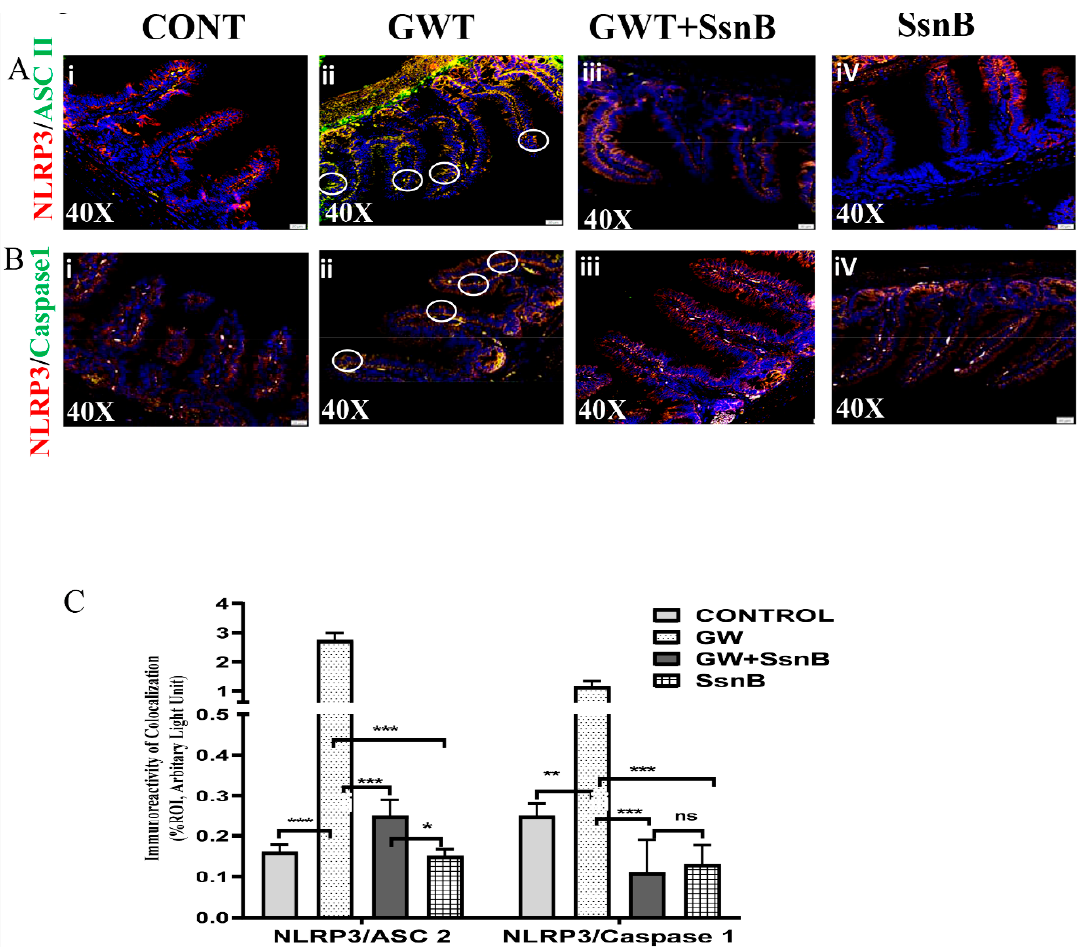
Figure 4. SsnB attenuates GW chemical-induced nod-like receptor protein 3 (NLRP3) inflammasome activation in the GWI mouse model. Activation of TLR4 signaling by HMGB1 may further activate the NLRP3 inflammasome complex, which exacerbates a pro-inflammatory response through secretion of inflammatory cytokines. The colocalization study of NLRP3 (red) / ASC2 (green) (Figure 4A) and NLRP3 (red) / Caspase 1 (green) (Figure 4B) was performed using an immunofluorescence microscopy in small intestine sections of CONT ( n = 3) (wild-type mice which were treated with vehicle), GW ( n = 3) (GW chemical exposed group), GW + SsnB ( n = 3) (group exposed with GW chemicals and SsnB), and SsnB ( n = 3) (group treated with SsnB only). Colocalizations were observed in the epithelial cells of the villi as yellow dots and are marked in the representative images by white circles. Images were taken at 40 × magnification. Bar graphs depicting morphometric analysis of NLRP3 / ASC2 and NLRP3 / Caspase 1 (Figure 4C) colocalizations are represented as mean ± SD of the %ROI (mean value calculated from three separate fields of a section of the small intestine). Significance was analyzed by unpaired T-test where * p < 0.05, ** p < 0.01, *** p <